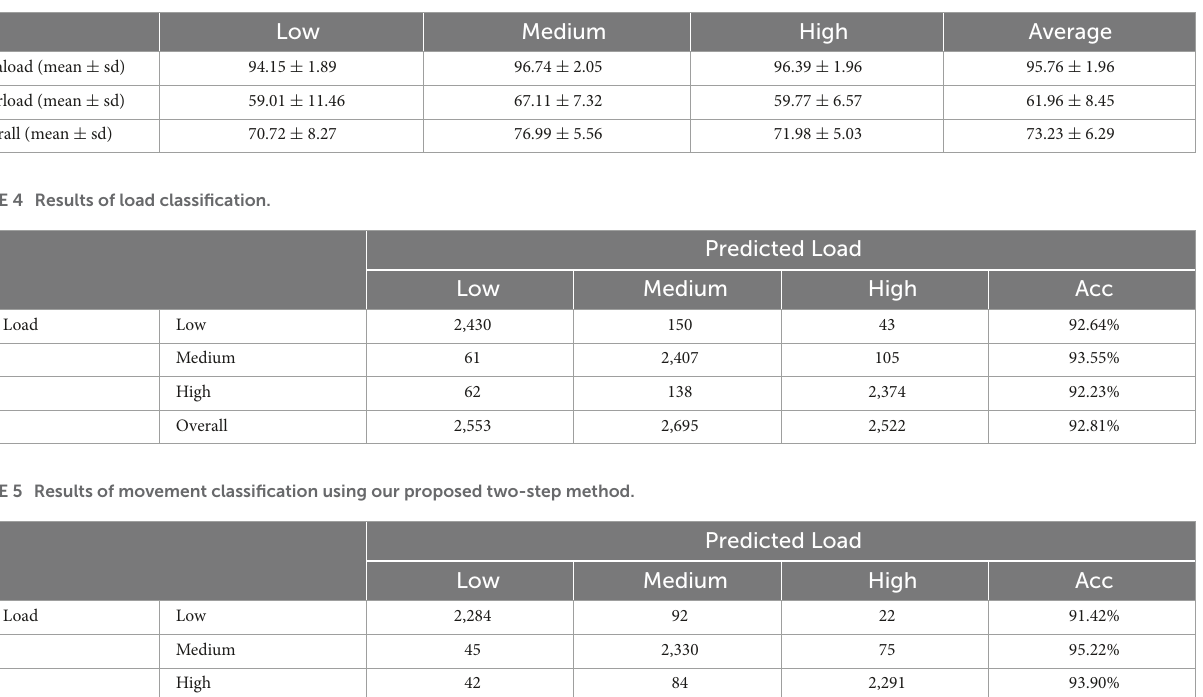
TABLE 3 Average value and variance of accuracy under intraload, interload, and all loads using a one-step method.